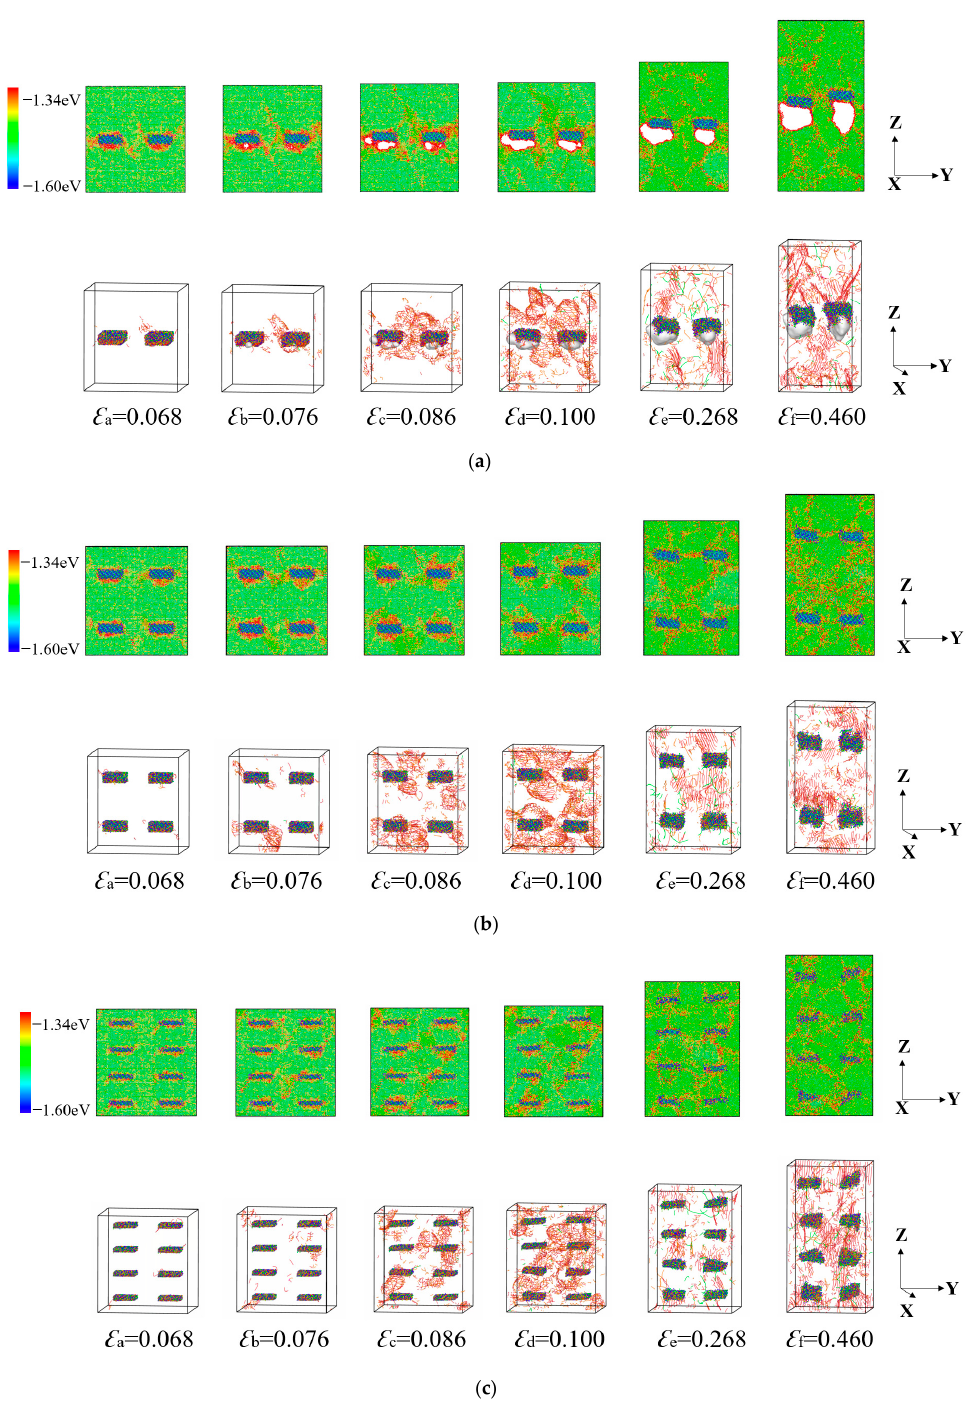
Figure 10. Potential energy cross-section, void, and dislocation evolution diagrams of the systems with multiple precipitates: ( a ) 2 precipitates; ( b ) 4 precipitates; ( c ) 8 precipitates.